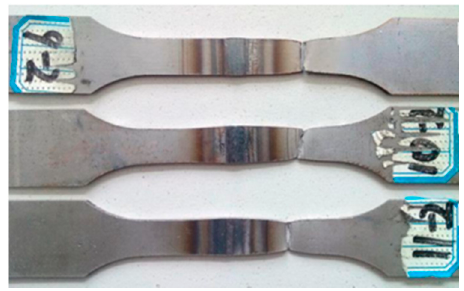
Figure 12. Shapes and fracture position of tensile specimens after stretching.